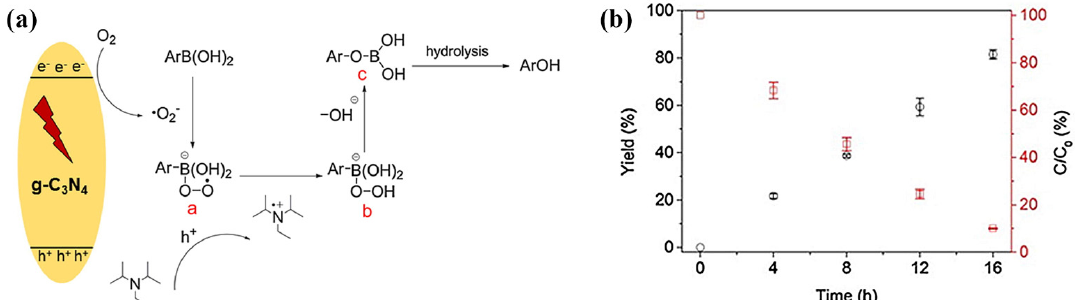
Figure 11. ( a ) Schematic diagrams of possible reaction mechanisms over g-C 3 N 4 under solar light irradiation. ( b ) Time courses of oxidative hydroxylation of arylboronic acid using g-C 3 N 4 /LMPET under solar light irradiation (yield—black; residual rate C/C 0 —red). Reprinted with permission from [52]. Copyright 2019, Elsevier.